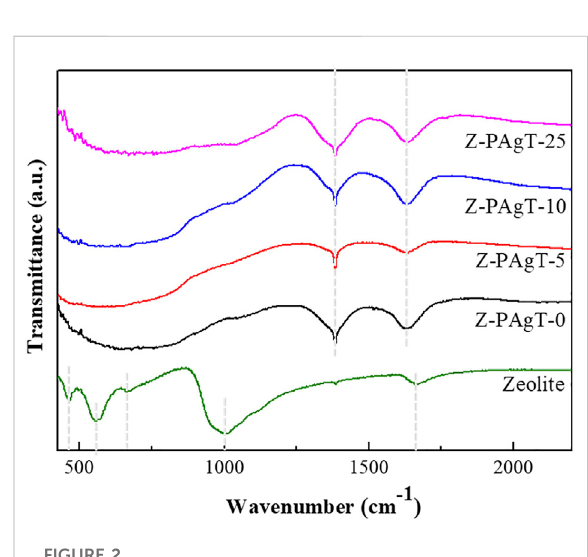
FIGURE 2 FT-IR spectra of the prepared Z-PAgT composite materials with different wt% zeolite addition and pure